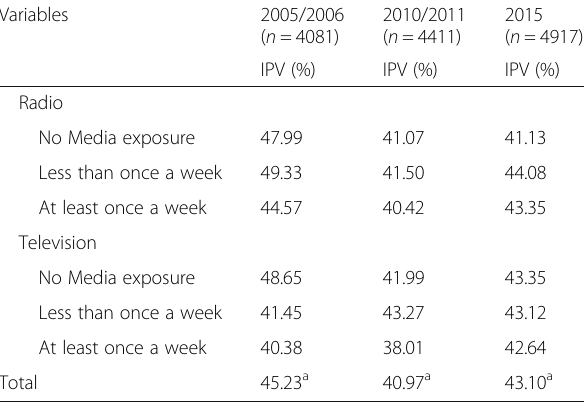
Table 1 Prevalence of IPV by sociodemographic characteristics,